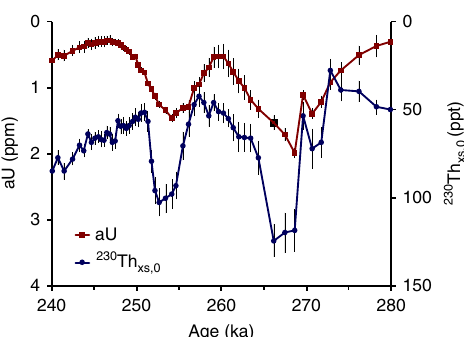
Fig. 4 Co-variation of 230 Th xs,0 and aU. Records of aU (red) and 230 Th xs,0 (blue) from site 17PC over MIS 8. Error bars represent 1 standard